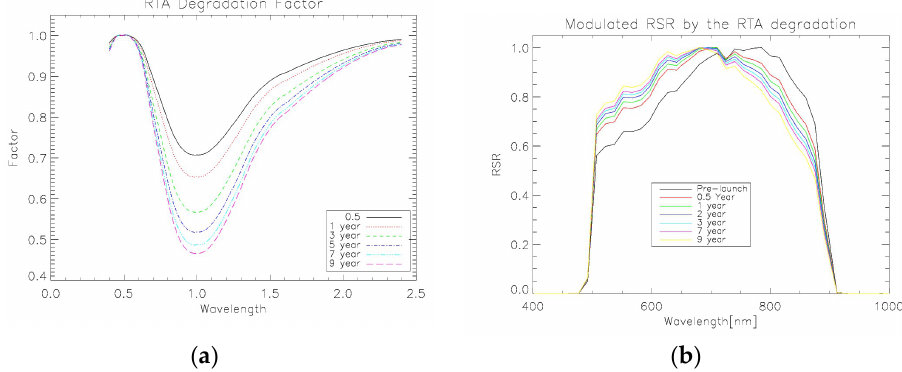
Figure 7. Time-dependent RTA darkening due to Tungsten oxides on the mirror surface ( a ) and corresponding modulated Relative Spectral Response (RSR) ( b